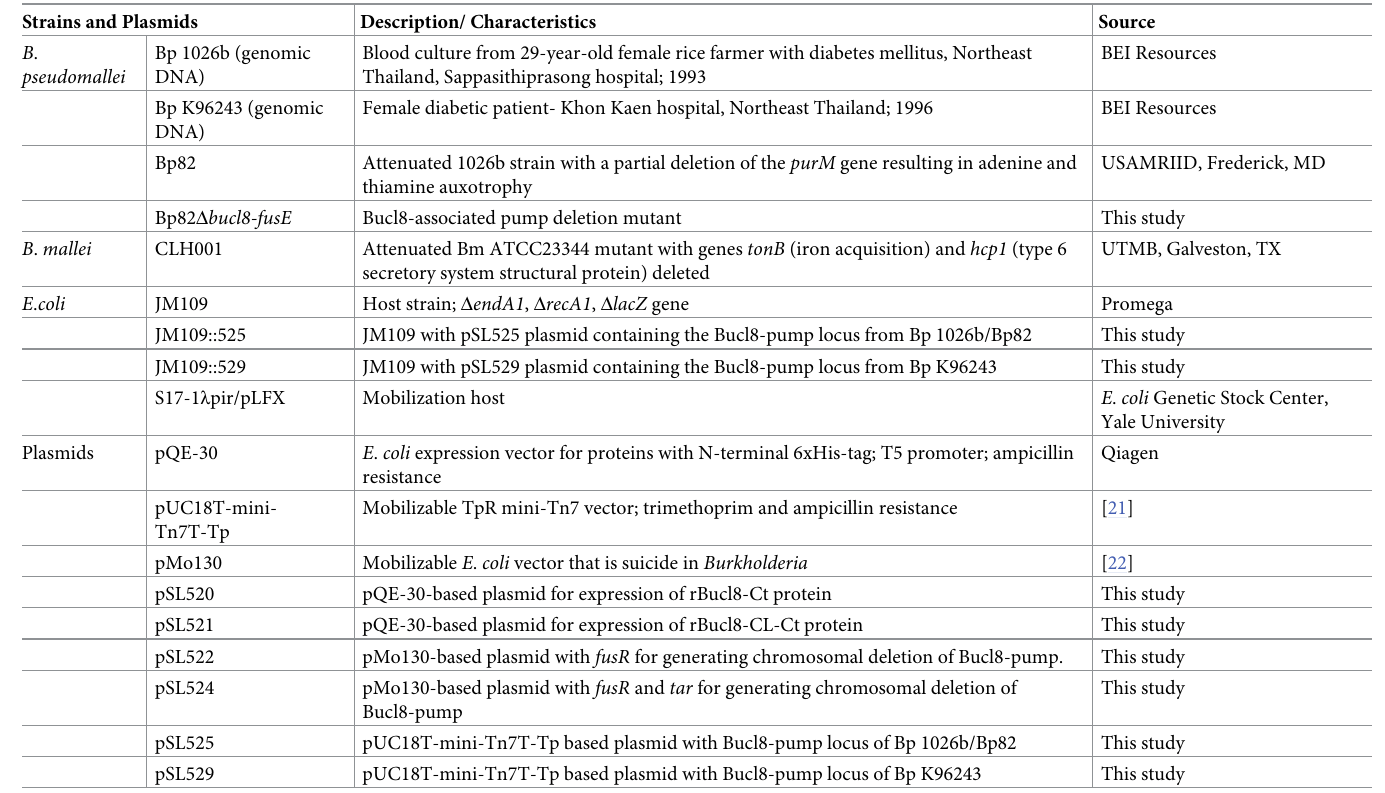
Table 1. Bacterial strains and